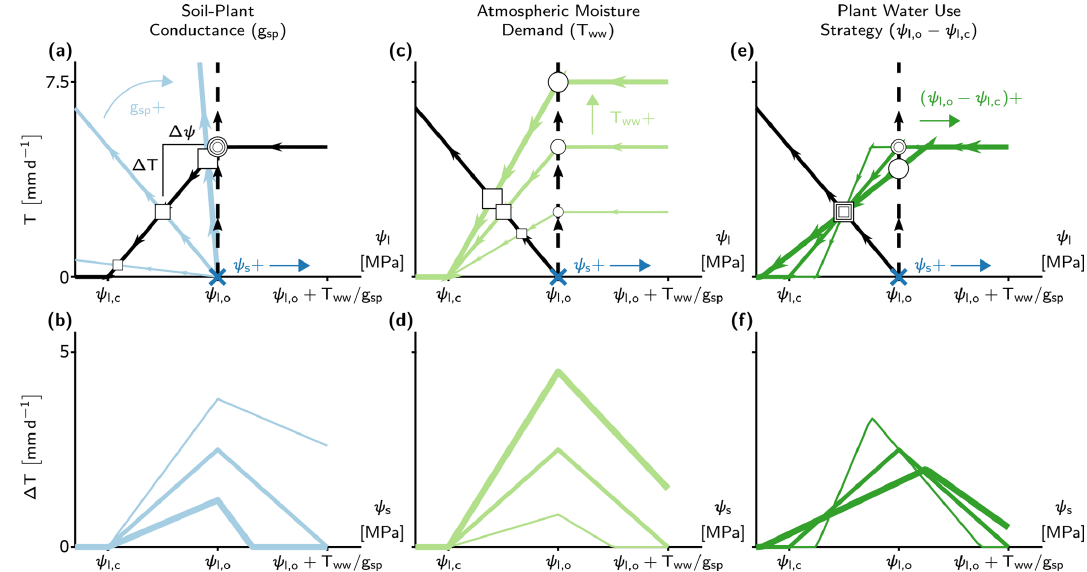
Figure 3. The effect of soil water potential ( ψ s ), soil–plant conductance ( g sp ), atmospheric moisture demand ( T ww ), and plant water use strategy ( ψ l , o − ψ l , c ) on differences between the minimalist PHM and β models ( (cid:49)T ). (a, c, e) Supply–demand curves at a single soil water availability (indicated by the dark blue x at ψ s = ψ l , o ) for three prescribed values of g sp , T ww , and ψ l , o − ψ l , c , respectively. Each parameter ( g sp , T ww , or ψ l , o − ψ l , c ) is set at 50% above (below) its base values at g sp = 10mmd − 1 MPa − 1 , T ww = 5mmd − 1 , ψ l , o = − 1MPa, and ψ l , c = − 2MPa using thick (thin) colored lines. The squares (circles) indicate the PHM ( β ) solutions, with size corresponding to magnitude of the changing parameter values. Note that the vertical distance between a correspondingly sized circle and square is (cid:49)T , and horizontal distance is (cid:49)ψ . (b, d, f) The (cid:49)T results from panels (a) , (c) , and (e) calculated for a range of ψ s with line thickness proportional to parameters in the aforementioned panels (e.g., thick blue line in panel b corresponds to 50% increase in g sp shown in panel a) . The x axes are mapped from ψ l in the top panels to ψ s in the bottom